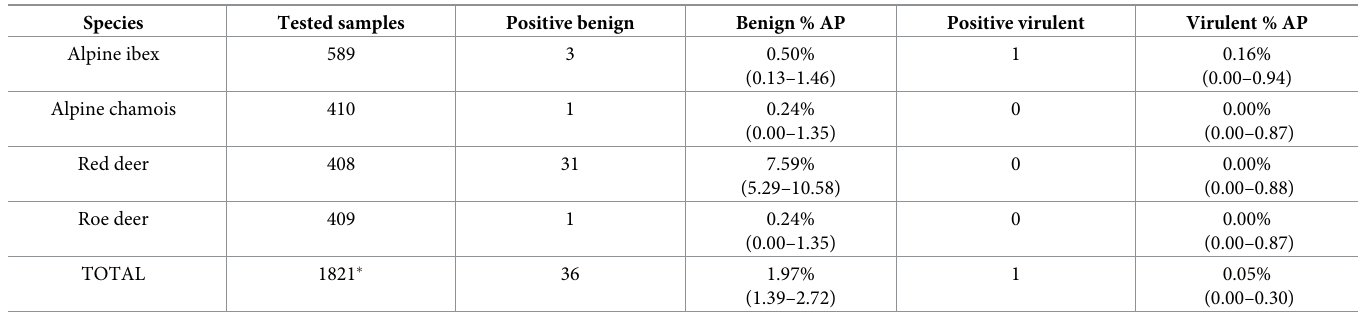
Table 1. Prevalence of D . nodosus in Swiss wild ungulates. Species